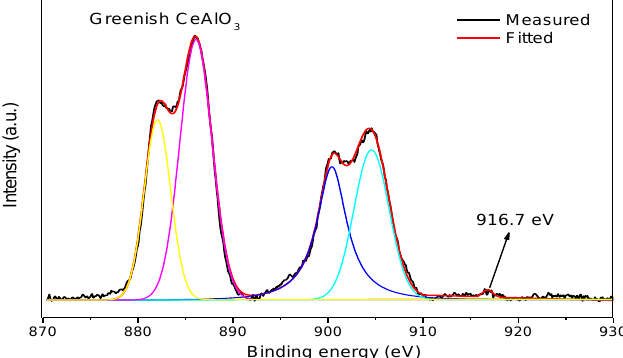
Figure 4. Ce3d XPS spectrum of the greenish CeAlO 3 crystal sample.